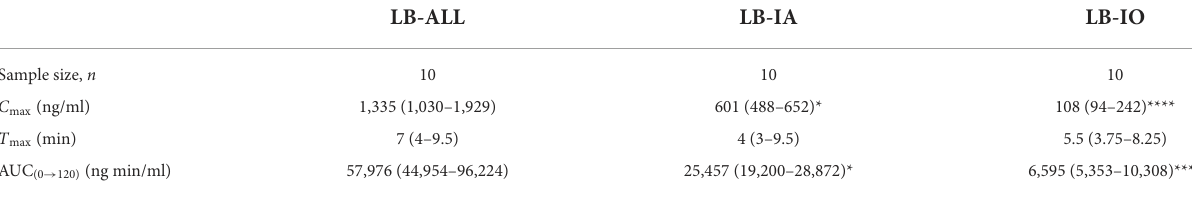
TABLE 1 The calculated pharmacokinetic parameters of levobupivacaine.